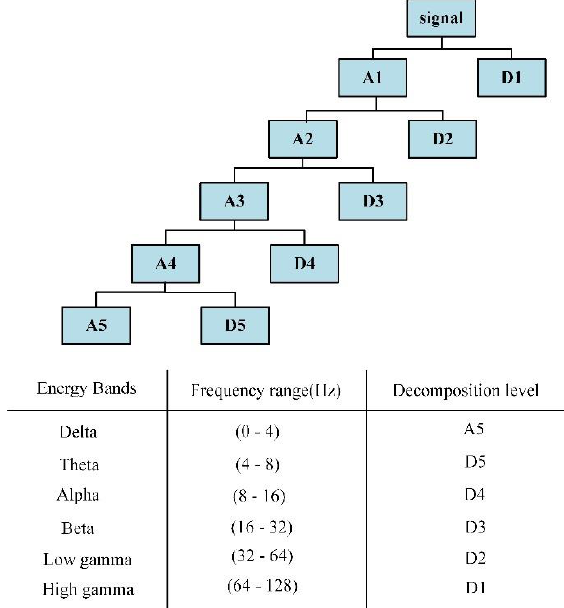
Figure 2. Relationship between the EEG band and wavelet decomposition tree